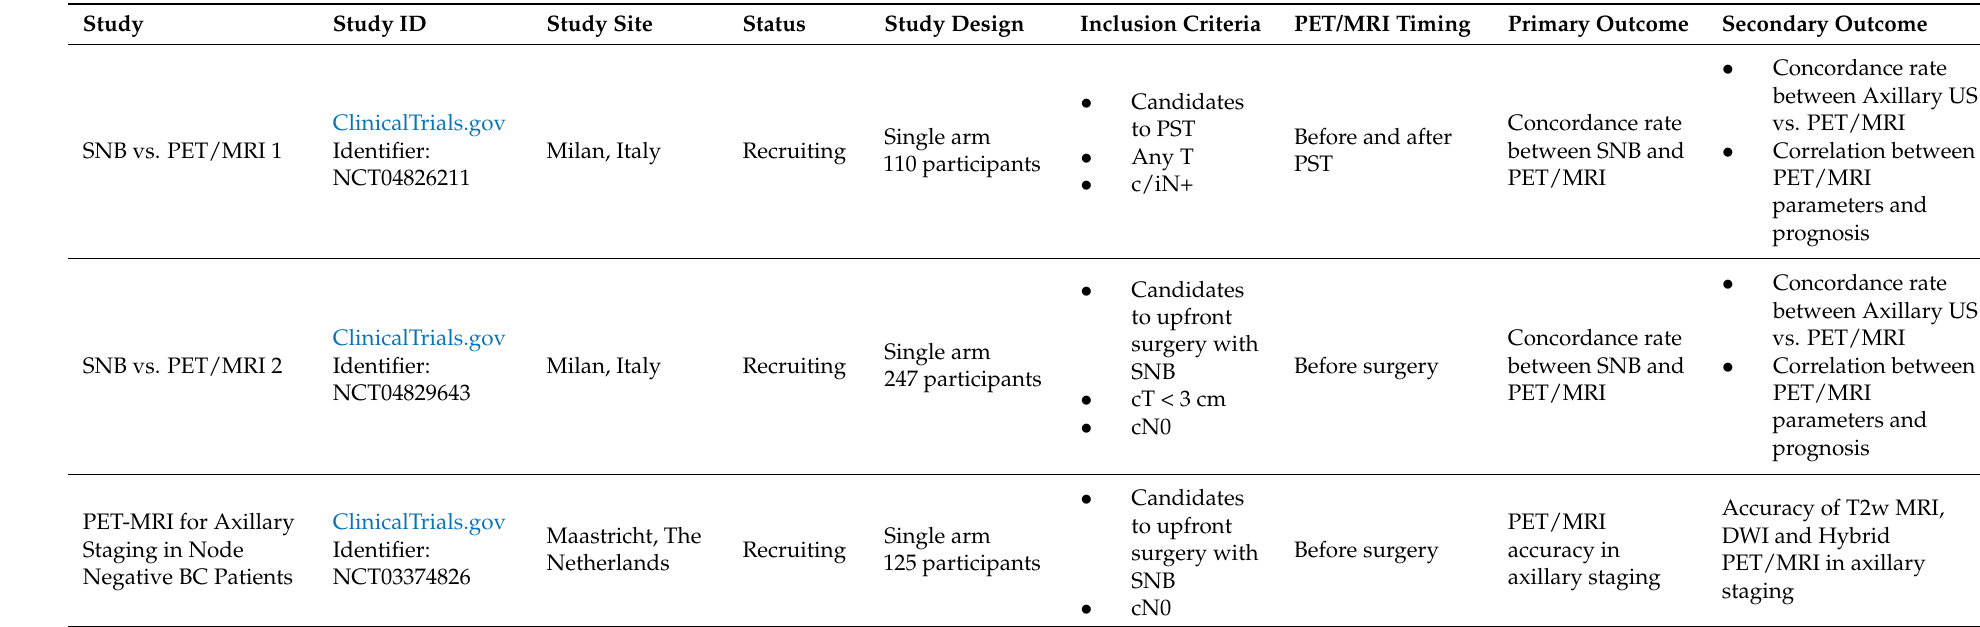
Table 3. Ongoing studies evaluating the performance of PET/MRI in staging the axilla. (PST = Primary systemic Therapy, SNB = sentinel node biopsy, BC = breast cancer, TN = triple